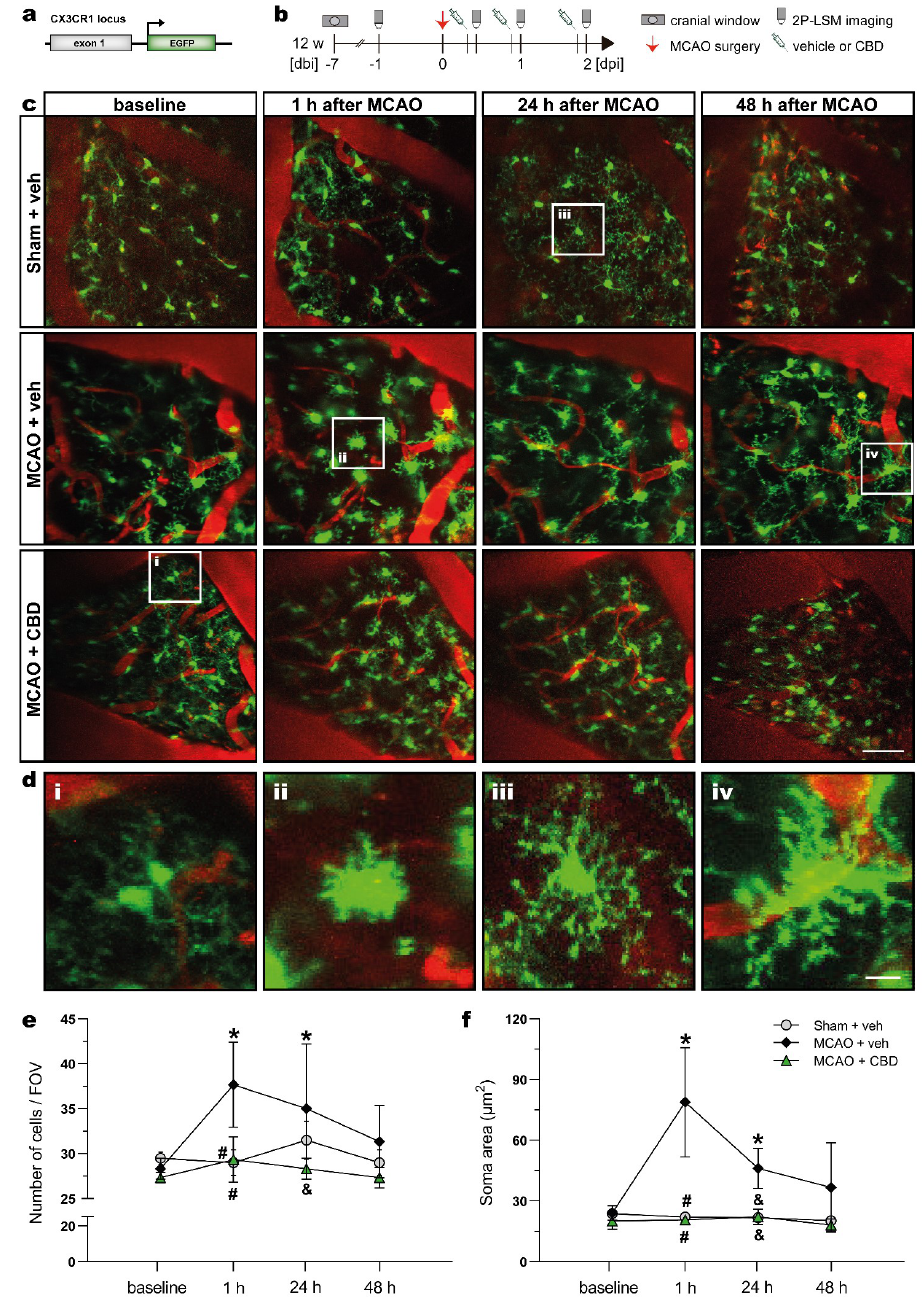
Figure 3. In vivo 2P-LSM demonstrated reduced microglial activation in the cortex of ischemic